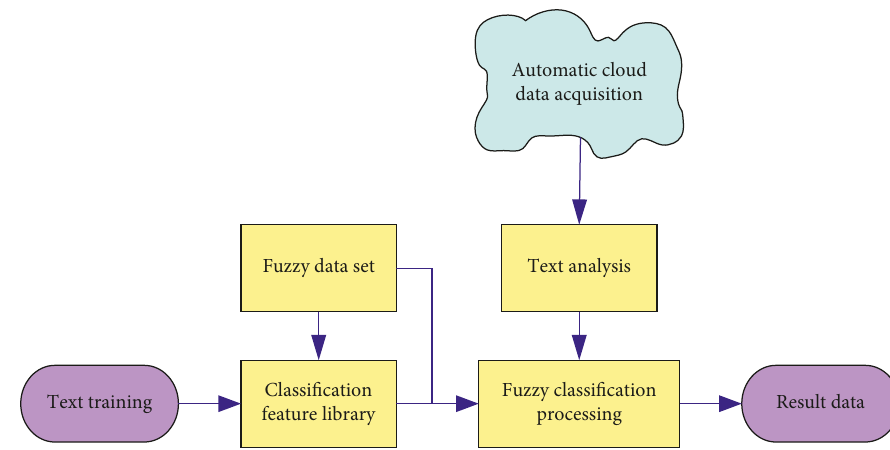
Figure 6: Schematic diagram of feature classification process based on fuzzy